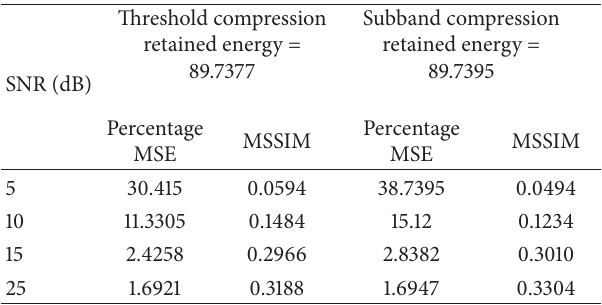
Table 1: IQA (MSE and MSSIM) metrics for different SNR and dif- ferent wavelet compression